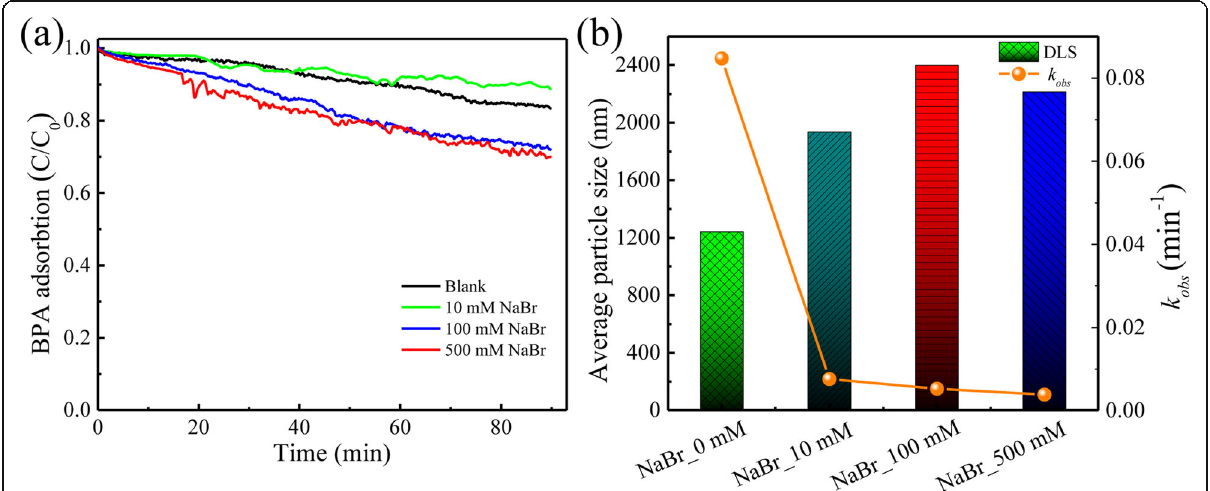
Fig. 7 ( a ) Sedimentation curve of ZnO NPs after loading different NaBr concentration, ( b ) effect of NaBr loading on average particle size distribution of ZnO NPs and the photocatalytic degradation rate